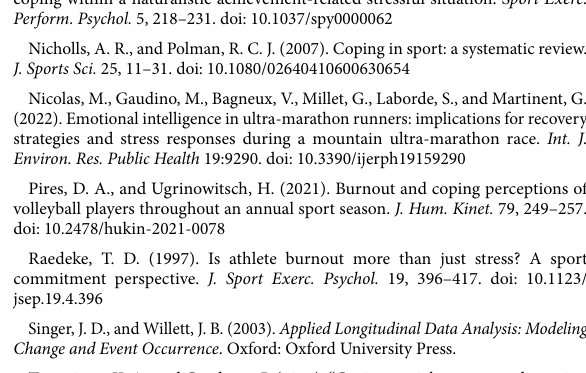
table-tennis. J. Sports Sci. 36, 2724–2731. doi: 10.1080/02640414.2018.1476730